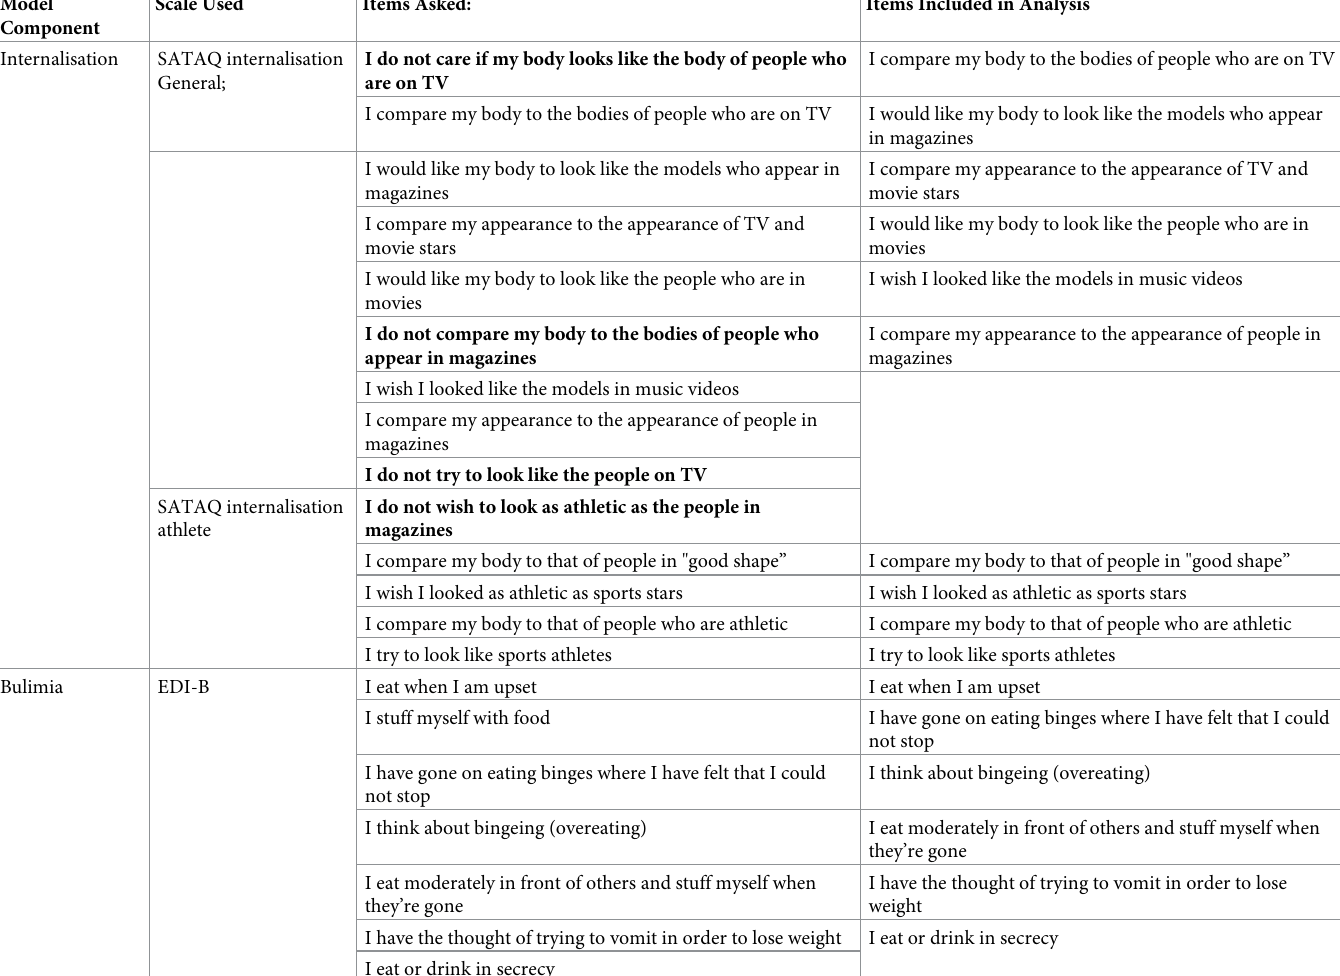
Secondly, having calculated mean scale (i.e. composite) scores for each construct measured, a series of path analysis models was then fitted to test the hypothesised cross-lagged mediation model, and its moderation by gender and lean/nonlean sport (Fig 2). When fitting the cross- lagged mediation model, analysis began with a model in which paths were free to differ across time. The stability of paths across time (stationarity) was then tested by fixing equal across time, in sequence: T1 to T2 and T2 to T3 autoregressive paths between the same variables across time; T1 to T2 and T2 to T3 paths from the predictors (social pressures and body dissat- isfaction) to the mediators (Internalisation and Negative Affect); and T1 to T2 and T2 to T3 paths from the mediators to the outcome (Bulimia). The aim was to show that these fixings did not significantly depreciate model fit, i.e. there was no evidence of variation in these relation- ships across time. The indirect effects from societal pressures and body dissatisfaction to the outcome of bulimia were then calculated to test whether mediation via internalisation and neg- ative affect respectively was occurring as hypothesised